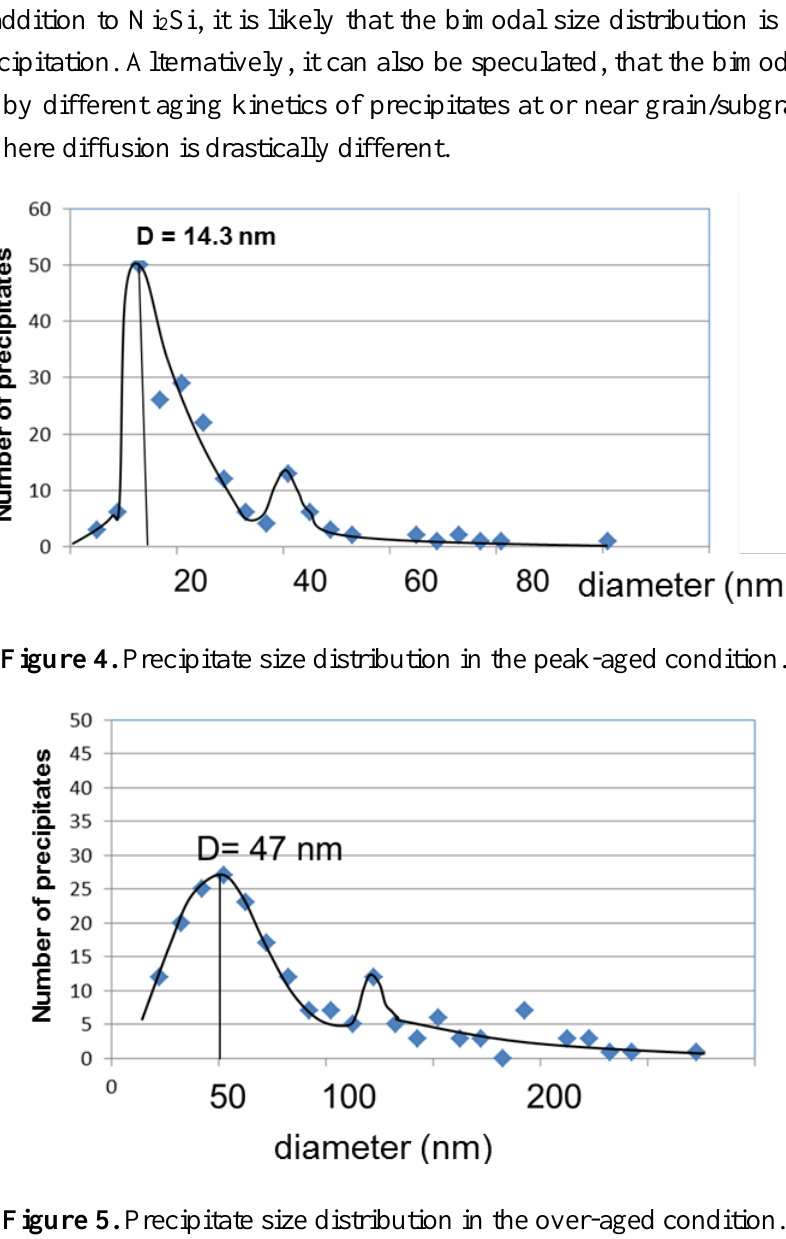
Figure 5. Precipitate size distribution in the over-aged